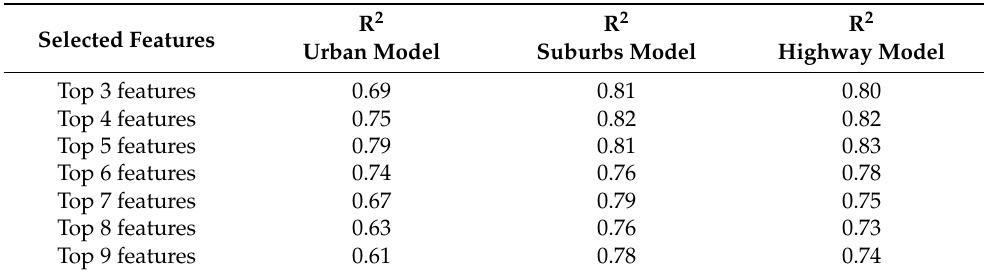
Table 12. Performance statistics results of using CO 2 models to predict the second route CO 2